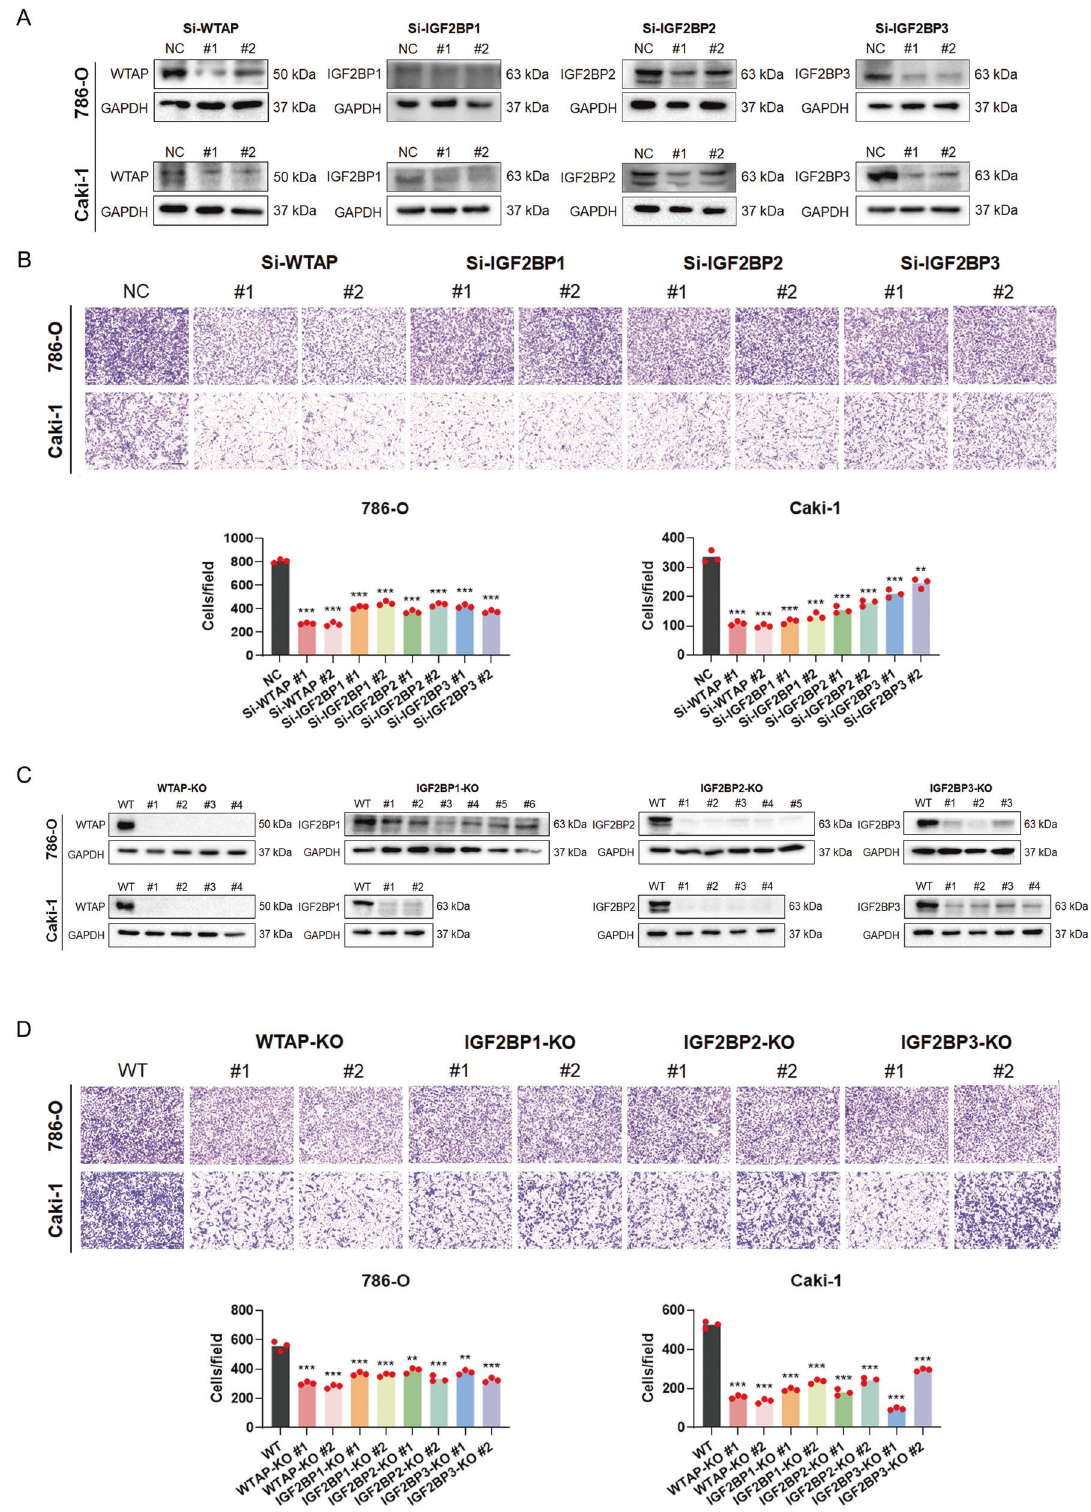
Fig. 3 WTAP and IGF2BPs promote RCC migration in vitro. A The indicated genes were knocked down by siRNAs in RCC cells. B WTAP and IGF2BPs knockdown individually suppressed RCC migration. Scale bar 250 μ m. C CRISPR-Cas9 mediated knockout (KO) of WTAP and IGF2BPs in RCC cells as detected by western blot. D WTAP and IGF2BPs KO individually suppressed RCC migration in vitro. Scale bar 250 μ m. * P < 0.05; ** P < 0.01; *** P <